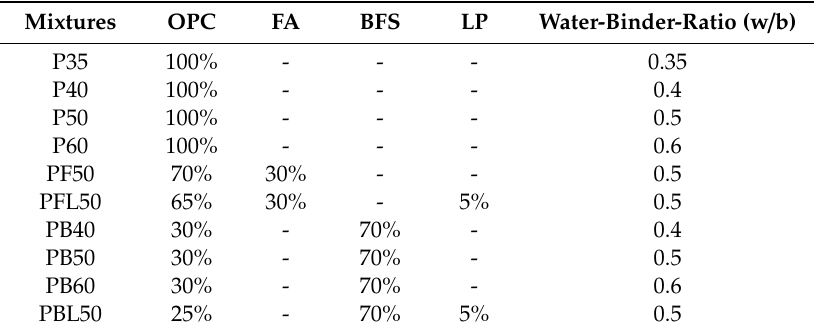
Table 2. Mix proportions (weight percentage) used for the binders.